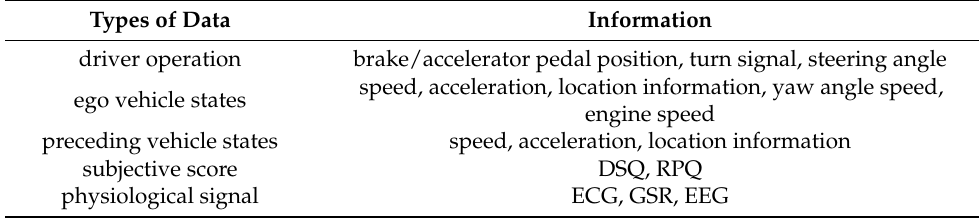
Figure 3. Experimental Process. Table 1. Data acquisition information.